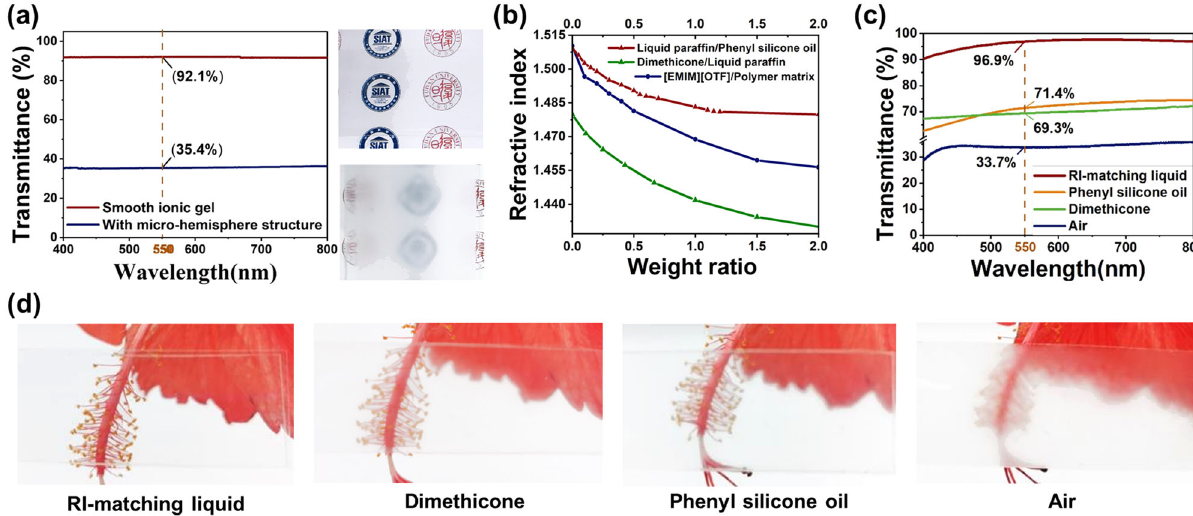
Fig. 4 The optical performance of the TIS device. a The visible spectrums of the ionic gel with and without surface micro-structure; b the RIs of the ionic gel and the RI-matching liquid with different components; c the visible spectrums of the TIS devices fi lled with the mediums with different RIs; d the comparison on the brightness and clarity of the images under the TIS devices using different mediums fi